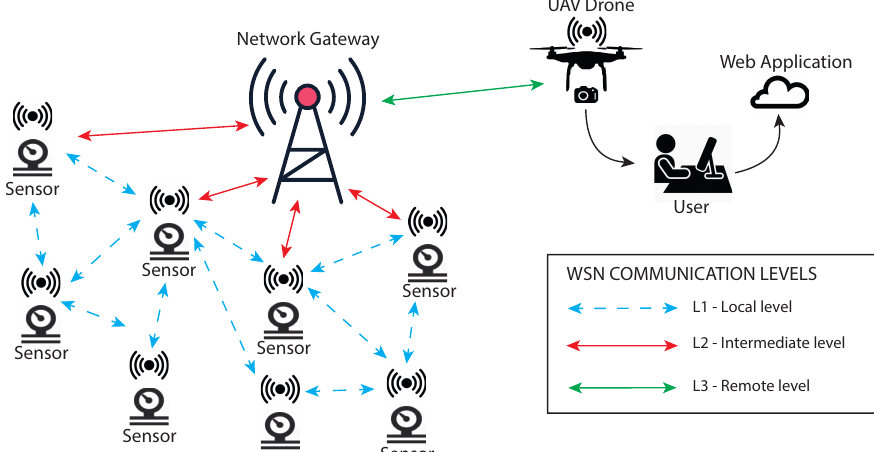
Figure 1. Smart framework concept.